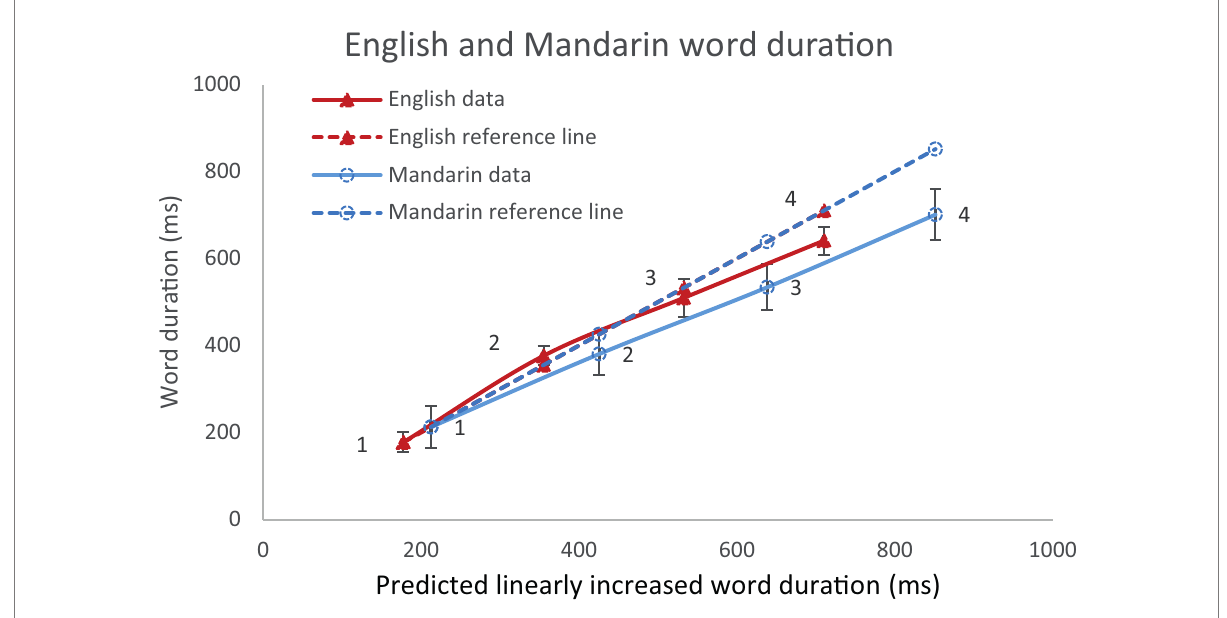
FIGURE 11 Word duration in English and Mandarin as a function of predicted linearly increased word